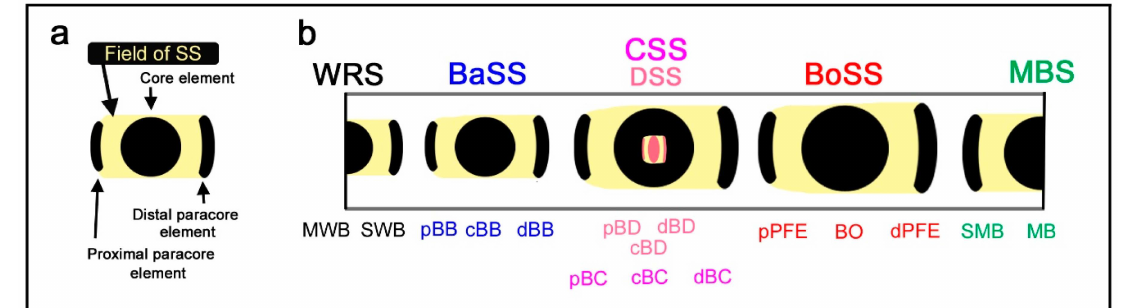
Figure 1. Simplified schematic representation of the nymphalid groundplan (NGP). For the most recent wing shape version of the nymphalid groundplan, see Figure 1 in the previous study [12]. ( a ) General system configuration. This is the basic morphogenesis unit of the nymphalid groundplan. A core element is located at the center, and a pair of paracore elements are located on the distal and proximal sides of the core element. The area between the distal and proximal paracore elements is considered the field of the symmetry system. ( b ) The entire nymphalid groundplan. The distal side is to the right, and the proximal side is to the left. The full basic morphogenesis unit is repeated three times to construct the basal, central, and border symmetry systems, although the status of the basal symmetry system is tentative. In addition, the discal symmetry system is located within the central symmetry system. The half basic morphogenesis unit is repeated twice to construct the marginal band system and the wing root band system. Abbreviations: WRS: wing root band system, BaSS: basal symmetry system, CSS; central symmetry system, DSS: discal symmetry system, BoSS: border symmetry system, MBS: marginal band system, MWB: marginal wing root band, SWB: submarginal wing root band, pBB: proximal band of the basal symmetry system, cBB: central band of the basal symmetry system, dBB: distal band of the basal symmetry system, pBC: proximal band of the central symmetry system, cBC: central band of the central symmetry system, dBC: distal band of the central symmetry system, pBD: proximal band of the discal symmetry system, cBD: central band of the discal symmetry system, dBD: distal band of the discal symmetry system, pPFE: proximal parafocal element, BO: border ocellus, dPFE: distal parafocal element, SMB: submarginal band, MB: marginal